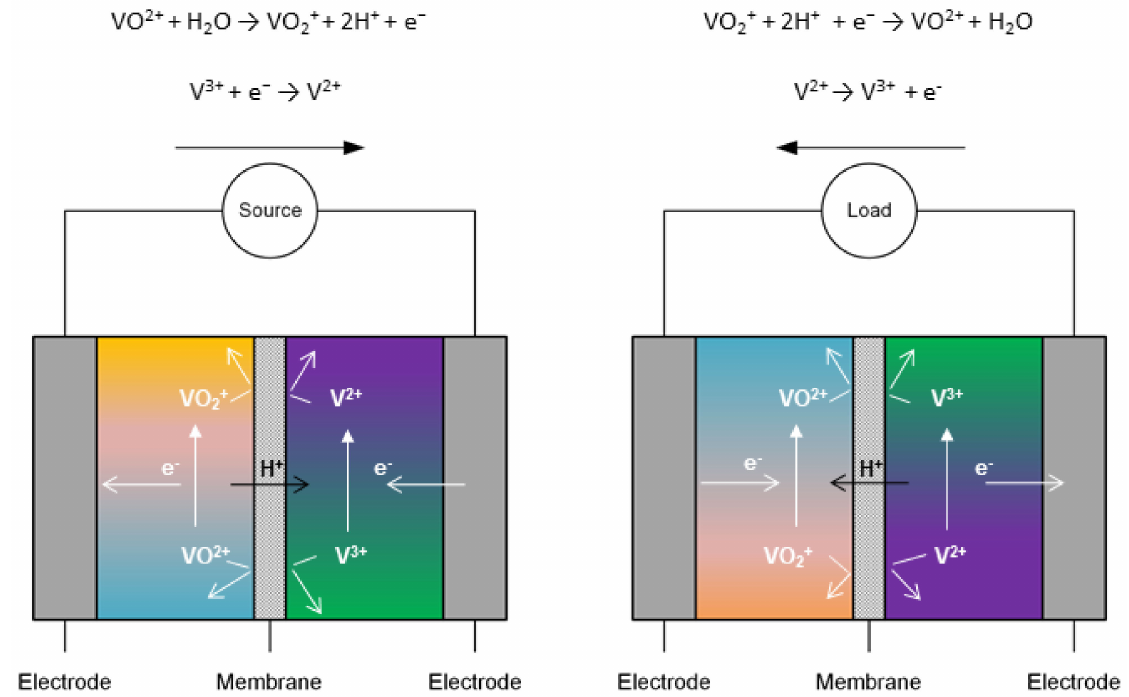
Figure 1. Schematic of the all-Vanadium redox flow battery ( left charging/ right discharging). Cost reduction is one way to realize marketable products. As an integral part of the VRFB, the membrane influences investment costs, service life and battery